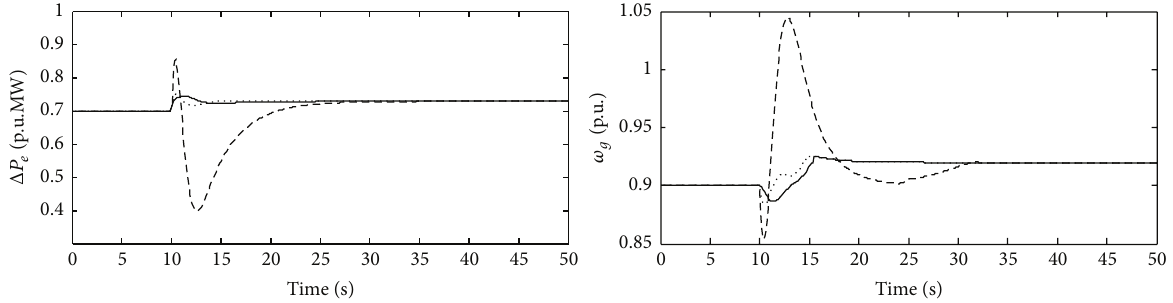
Figure 13: Wind turbine response of electrical power and rotor speed in Case 2: distributed MPC (solid line), centralized MPC (dotted line), and decentralized MPC (dashed line).